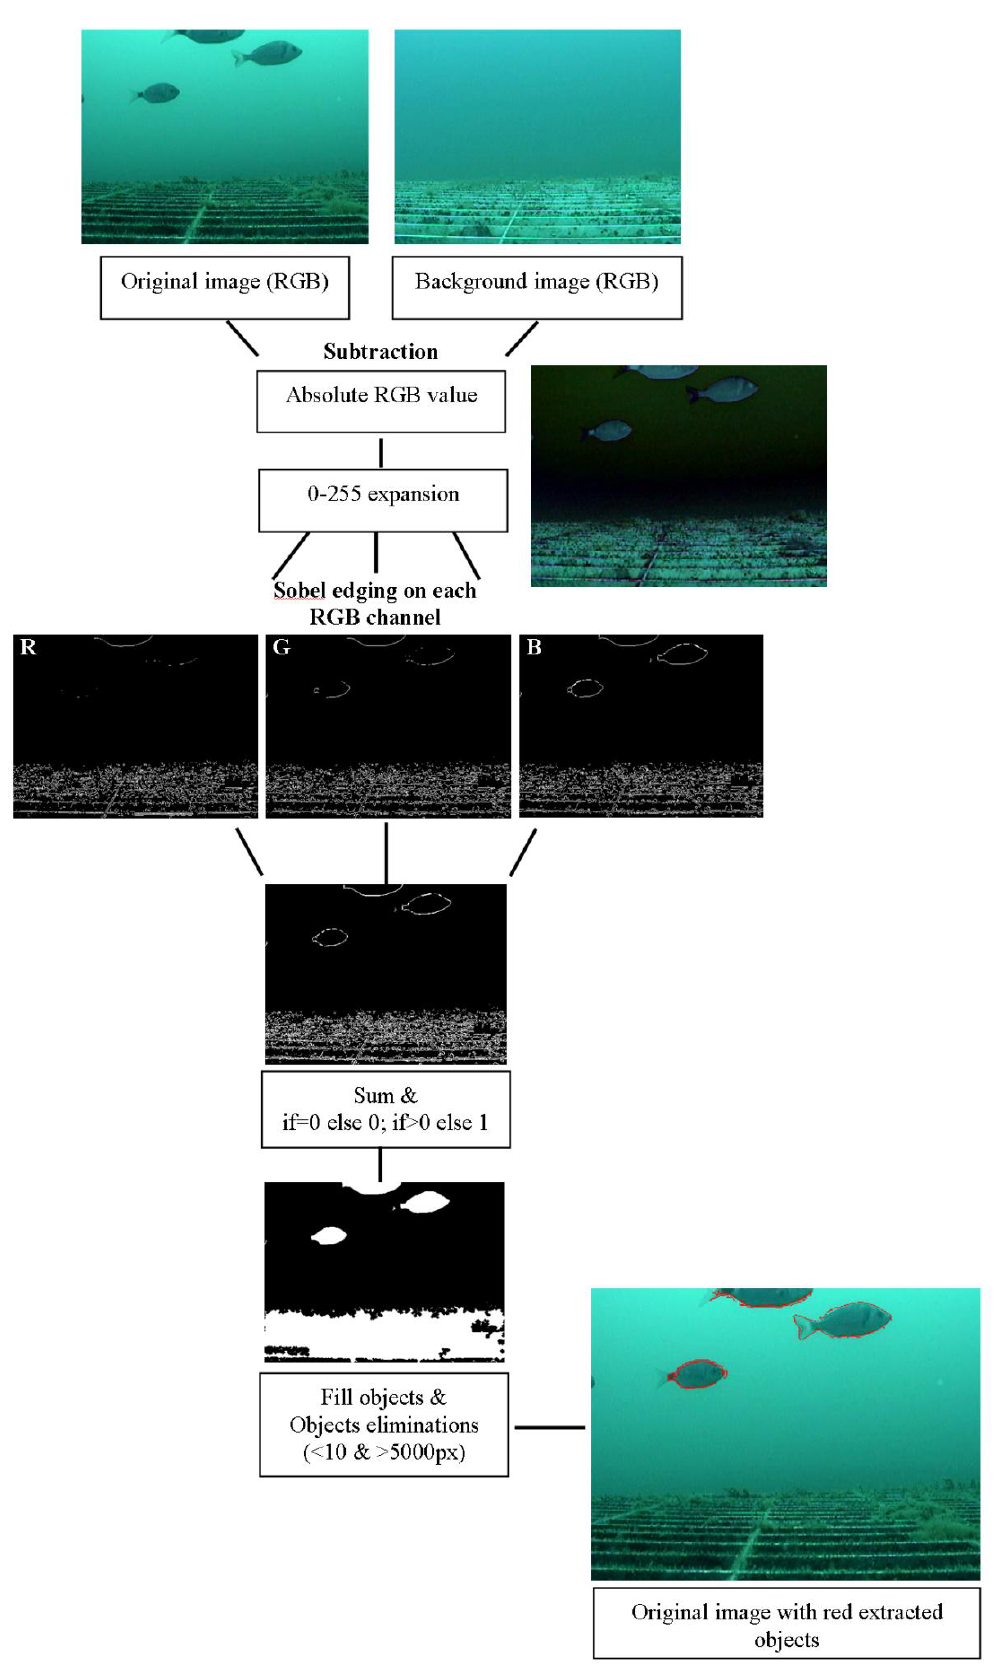
Figure 6. Diagram of the processing steps in the automated video image analysis protocol used to count fish in digital frames acquired by the OBSEA seafloor cabled